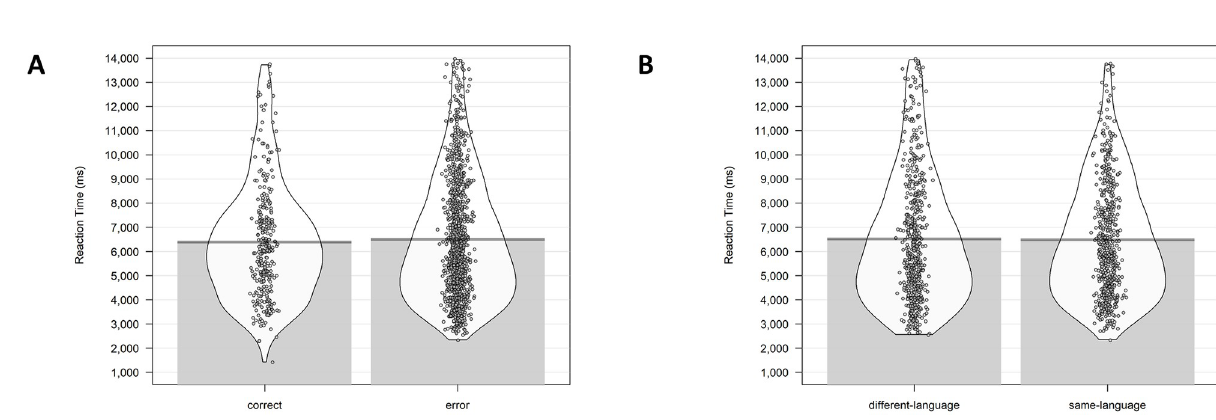
Fig 5. Analysis on Reaction Time for Study 2. (A) RT results between corrected answers and errors. (B) RT results between same-language and different-language errors. RTs in the figure are not transformed.